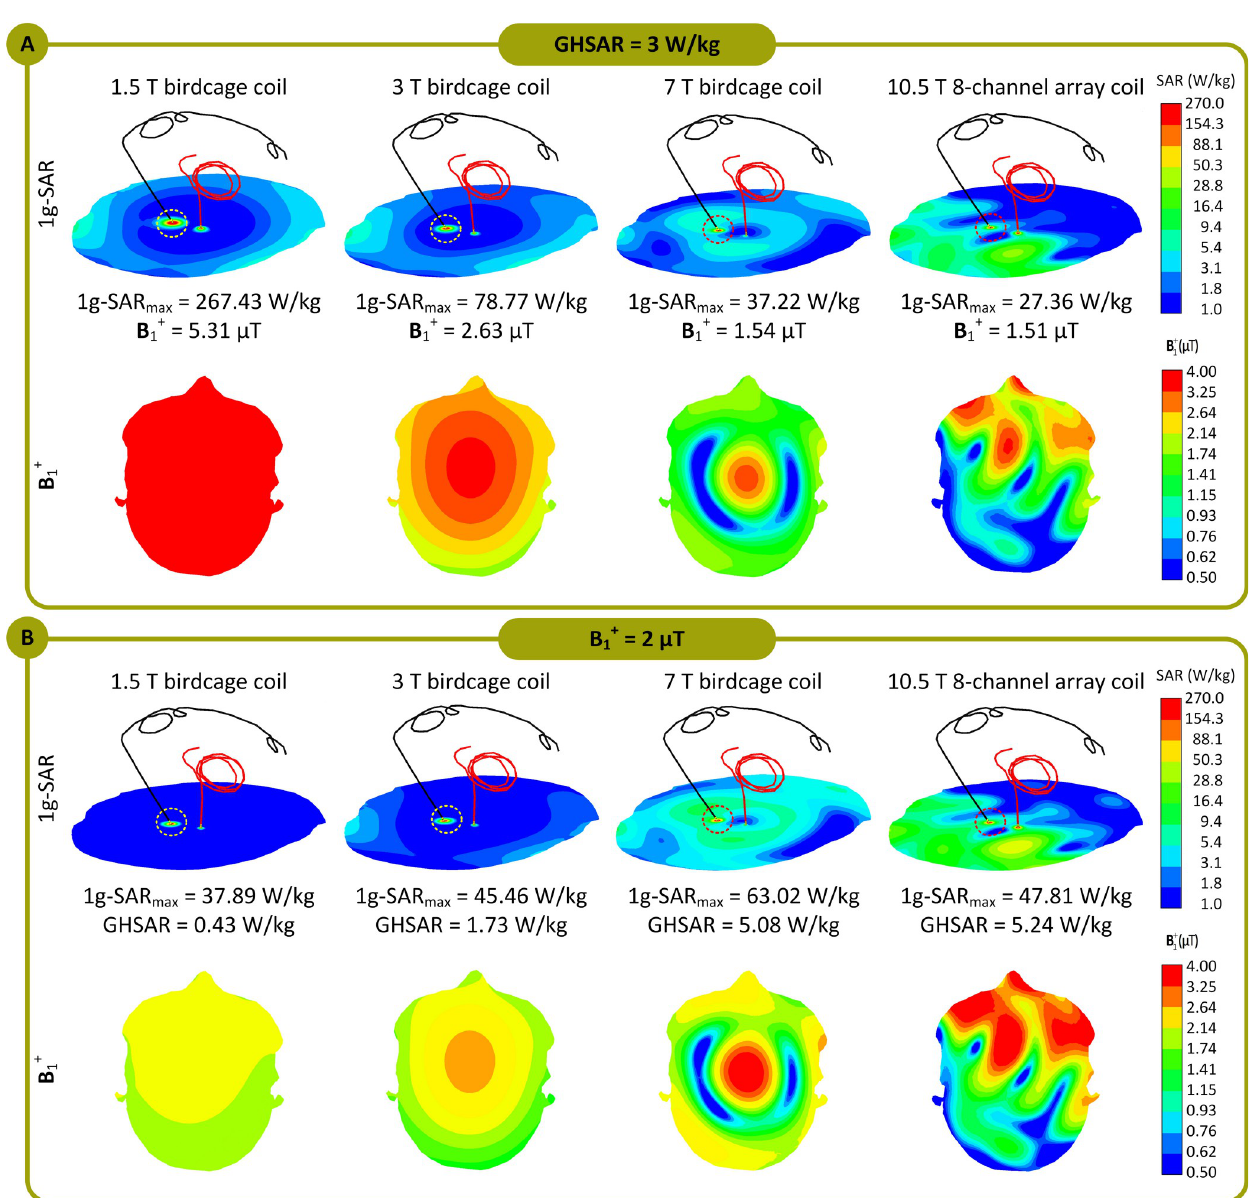
Fig 4. 1g-SAR distributions in patient 12 (ID12) for the 1.5 T, 3 T, 7 T, and 10.5 T coils over an axial plane passing through the electrode contacts. The coils’ input powers are adjusted (A) to generate a GHSAR of 3 W/kg and (B) to generate an average of B 1+ = 2 μ T over an axial plane passing through the patient’s forehead. The B 1+ field distributions over the mentioned axial plane, which passes through the patient’s forehead, are also presented. Additionally, 1g-SAR max , the average of B 1+ field, and GHSAR are also reported for all four